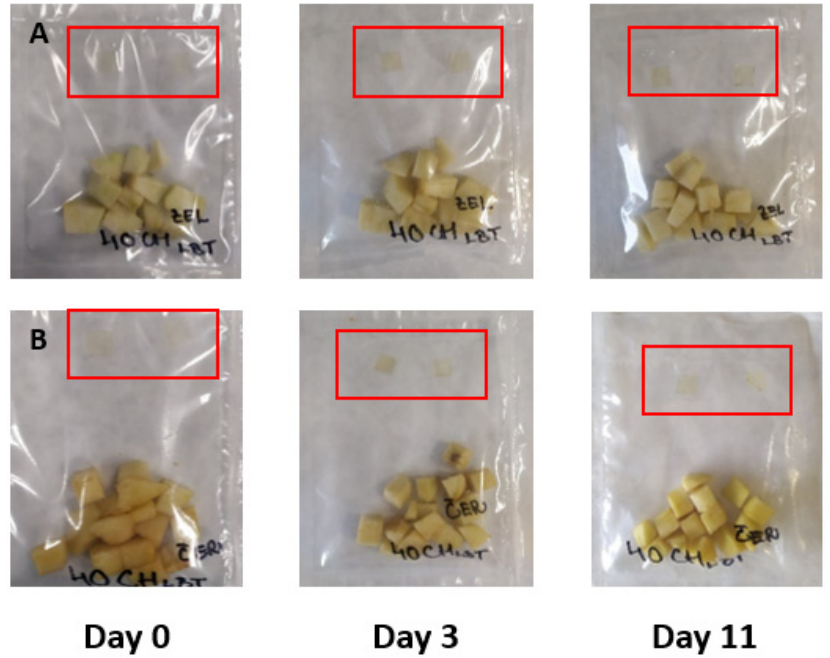
Figure 5. Green ( A ) and red ( B ) apples packaged with pieces of film made with the addition of sweet potato extract. Figure 6 summarized the results of intelligent properties of control chitosan films.